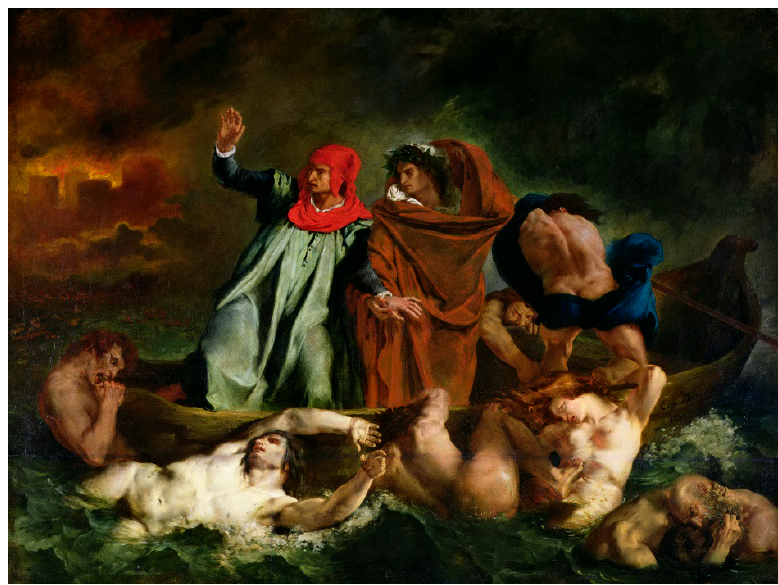
Figure 2. The Einstein Couple (Maria Einstein-Biilmann and Philip Einstein-Lipski), a poster for Lars von Trier’s The House that Jack Built , 2018. Courtesy of Zentropa and The Einstein Couple.